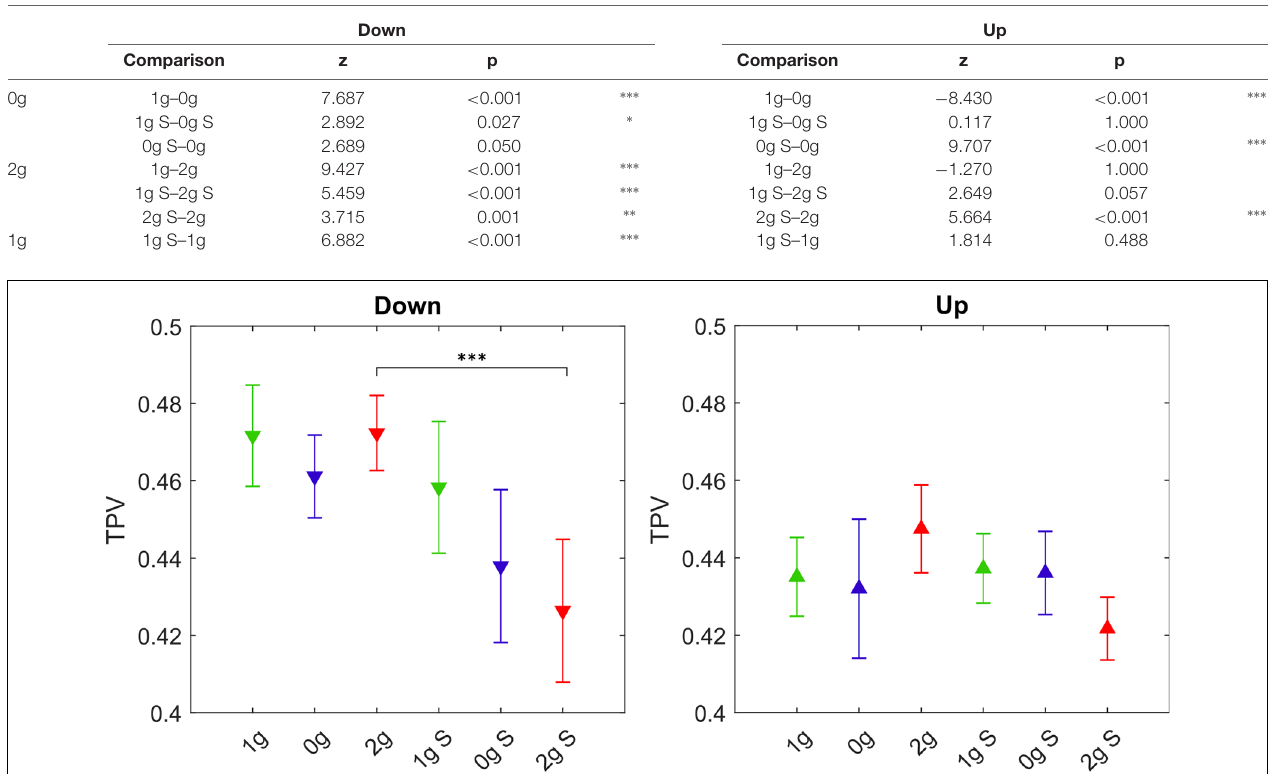
TABLE 4 | Post hoc analysis for maximum displacement in the x direction.